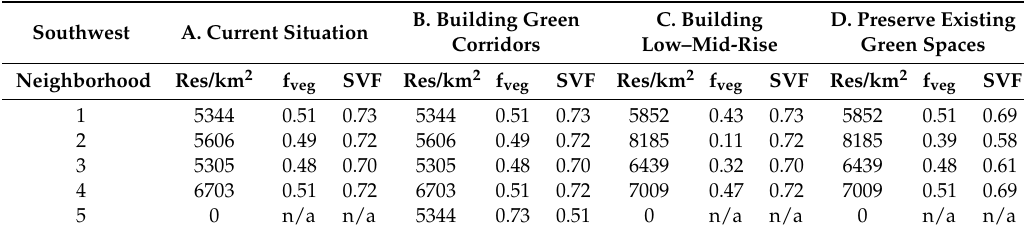
Table A1. Values used for the sky-view factor (SVF) and the vegetation fraction for urban planning strategies in The Hague Southwest. In addition, the density of residences is indicated. Neighborhoods are displayed in Figure 3.